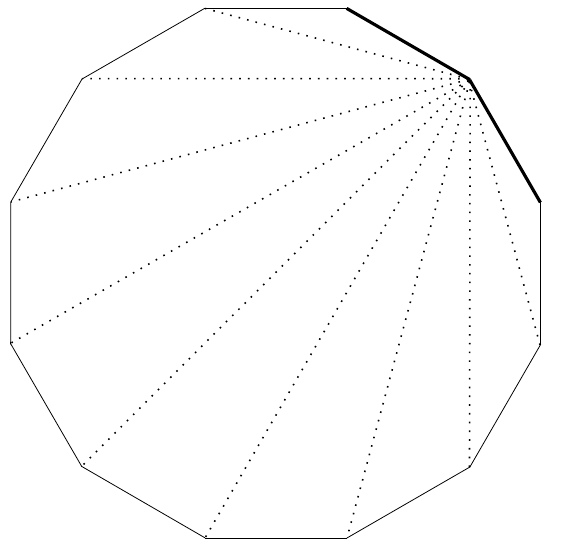
Figure 3 . Polygon representing the location of the rami(cid:12)cation zeroes. We represent with dotted lines all the diagonals of one vertex, and with thicker lines its two adjacent